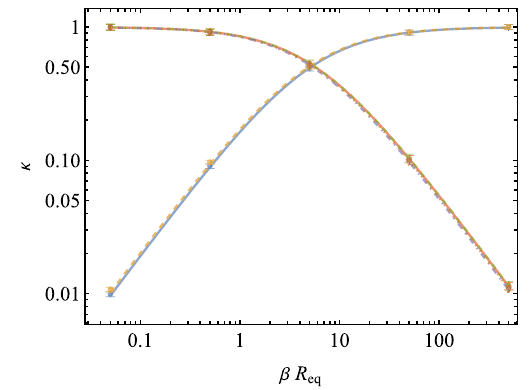
Fig. 5 The blue and red points with error bars show the amplitude of the GW spectrum from bubble collisions and from fluid motion, respec- tively, relative tothe R eq value that gives the largest amplitude. The blue andredcurvesshow κ bubbles and κ fluid ,respectively.Theparametersread ξ = 3 and v = 1 for both solid lines and the points of corresponding fluid colour. Dashed and dotted lines and their corresponding points show the remaining cases ( ξ = 2 and v fluid = c s ) which as we see largely